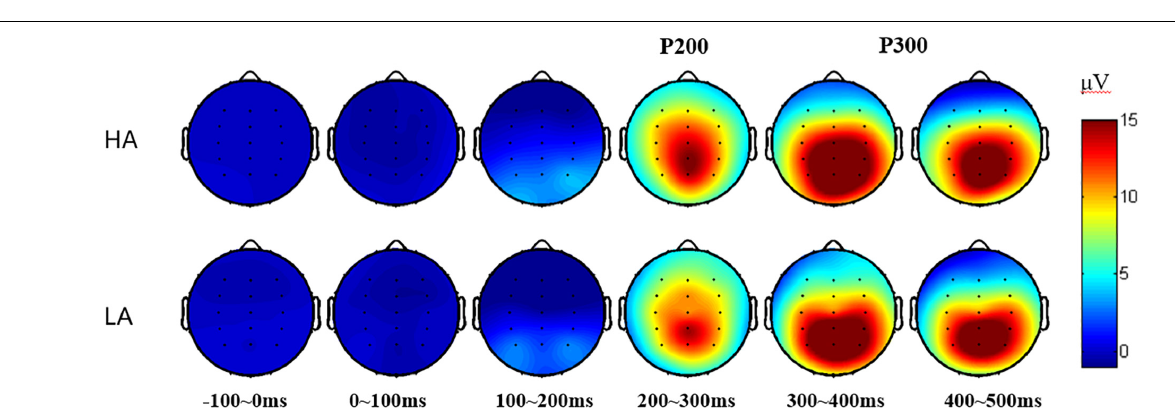
significantly (or marginally significant) higher than the LA group’s ACC for both tasks, while the HA group’s reaction time (RT) was shorter (non-significantly) than the LA group’s